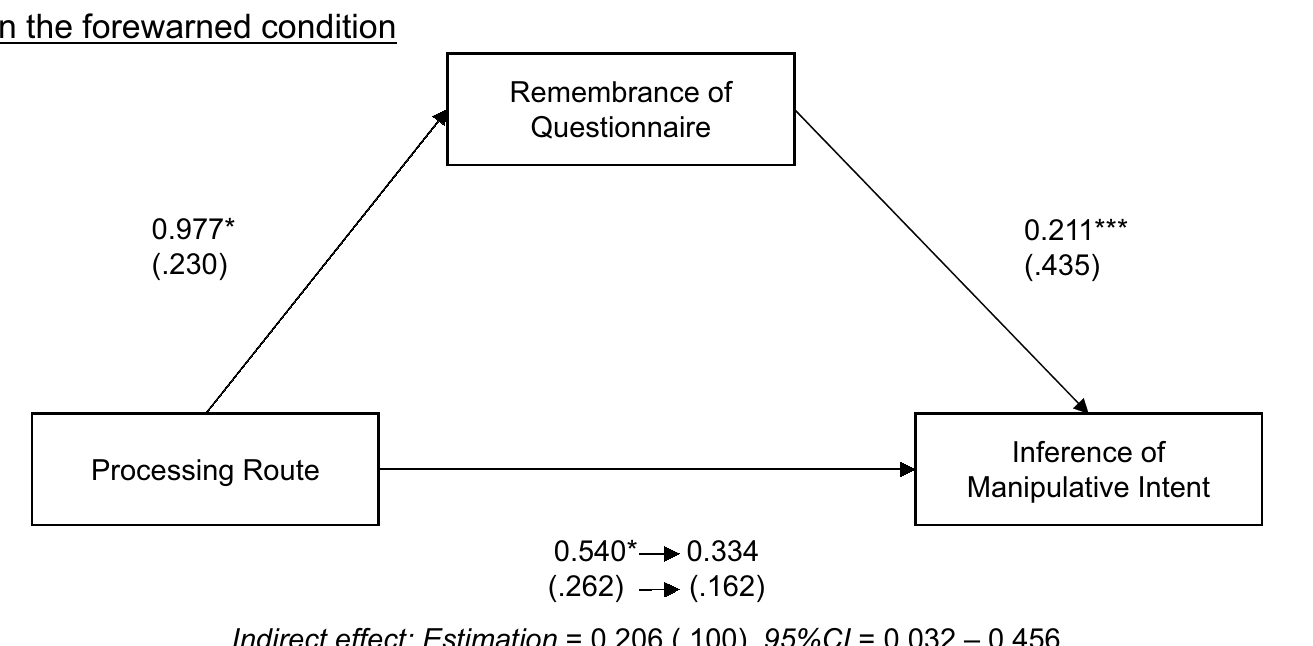
Fig 1. Mediation analysis: IMI mediated by remembrance of